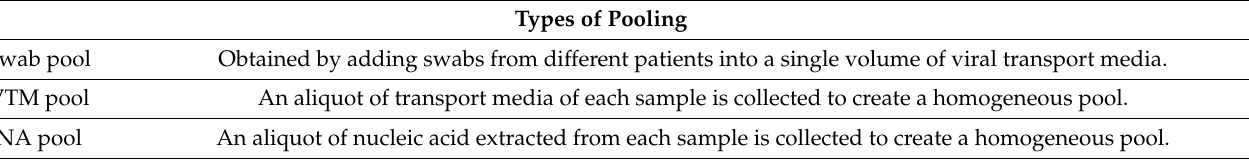
Table 1. A summary of the characteristics of pooling schemes and types. Types of